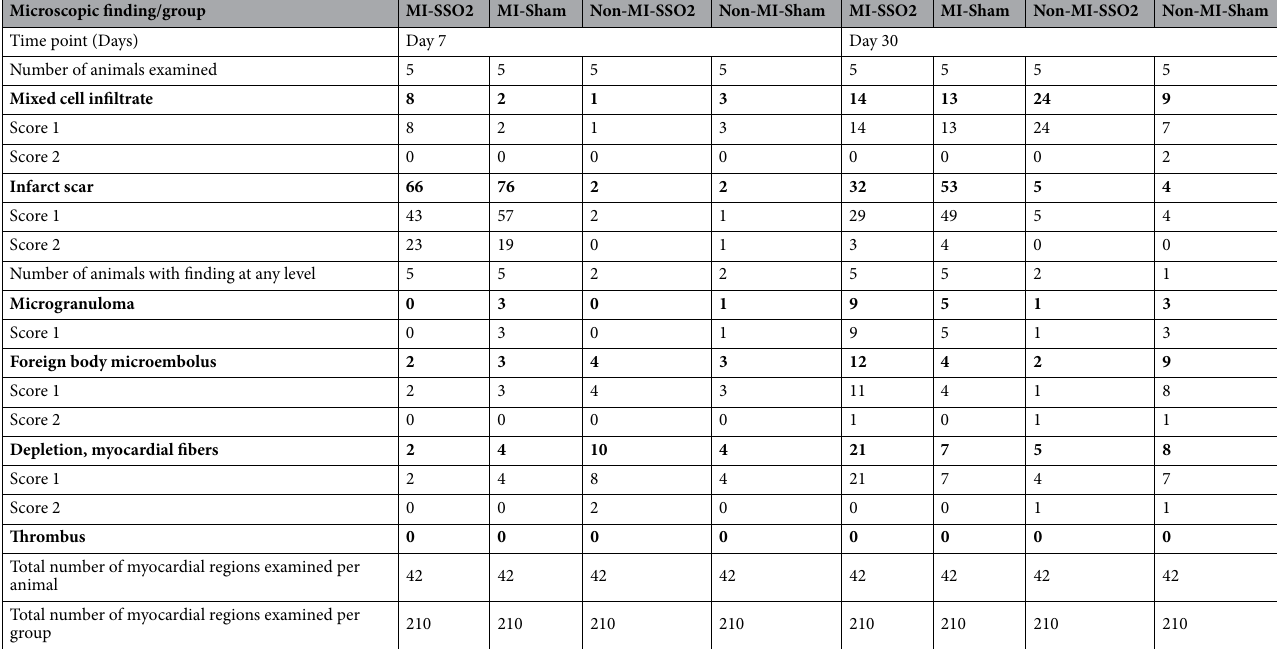
Table 2. Summary of myocardial microscopic changes of